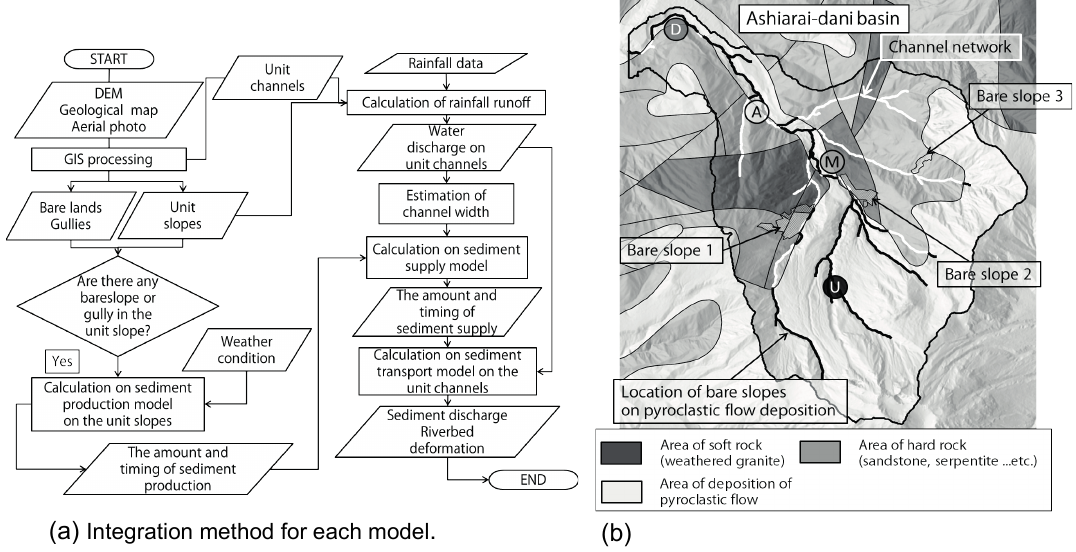
Fig. 4 (a) Integration method for each model. (b) Unit channels, categorized geological features, and sediment sources in the basin. Locations where calculation results were shown are denoted with circles.